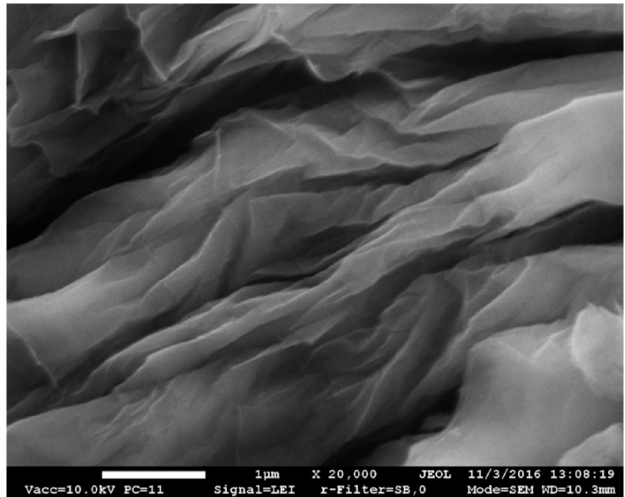
Figure 1. Scanning electron microscope (SEM) image of undispersed GO sheets.